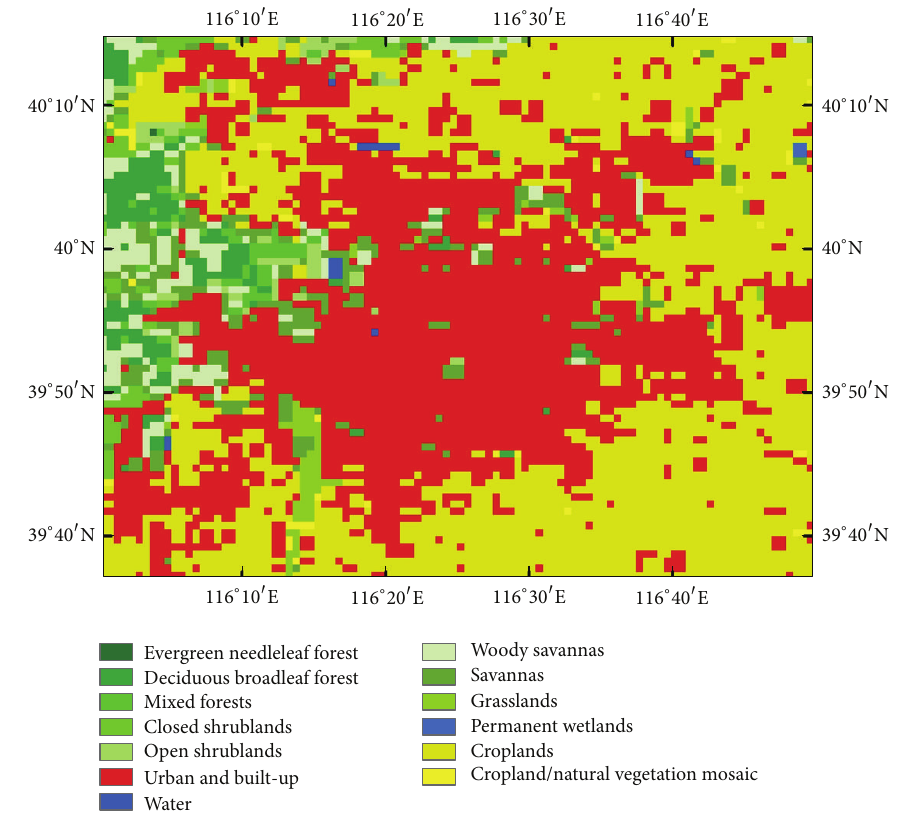
Figure 8: Spatial distribution of 2010 land